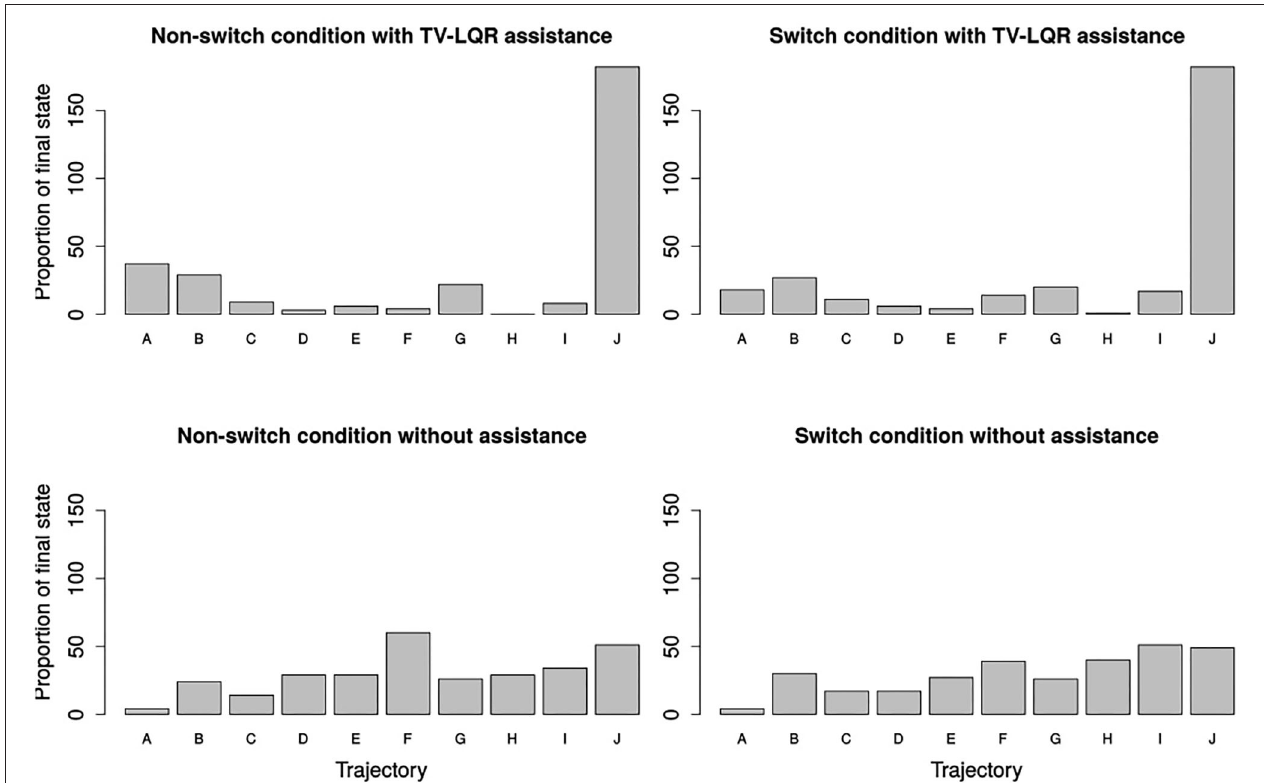
FIGURE 7 | Histogram with the frequency of the final system pose being closest to the target grasp pose. In the case of a random visitation frequency expected by chance, each target grasp, denoted by its trajectory name, would be frequented between five and six times (50 trials per